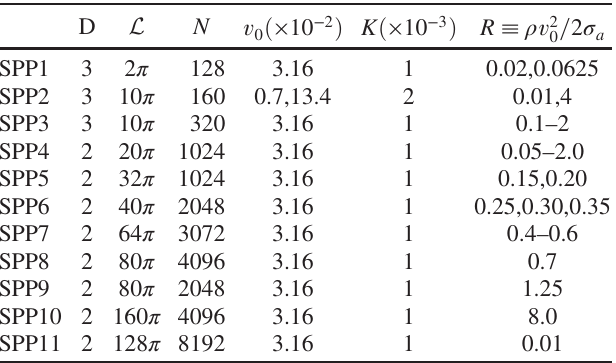
TABLE I. Spatial dimension D of the domain and parameters K , and R used in our direct numerical simulations. The L , N , v 0 , suspension density ρ ¼ 1 , λ ¼ 0 . 1 , and μ ¼ 0 . 1 and the rotational mobility Γ ¼ 1 are kept fixed for all the runs. Note that as R approaches R 2 the range of linearly unstable modes shrinks and is restricted to small wave numbers, i.e., large length scales. To